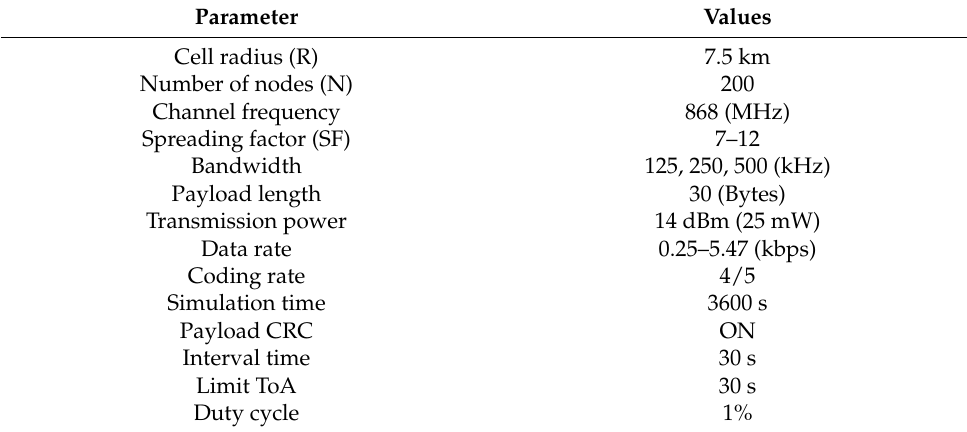
Table 3. Simulation